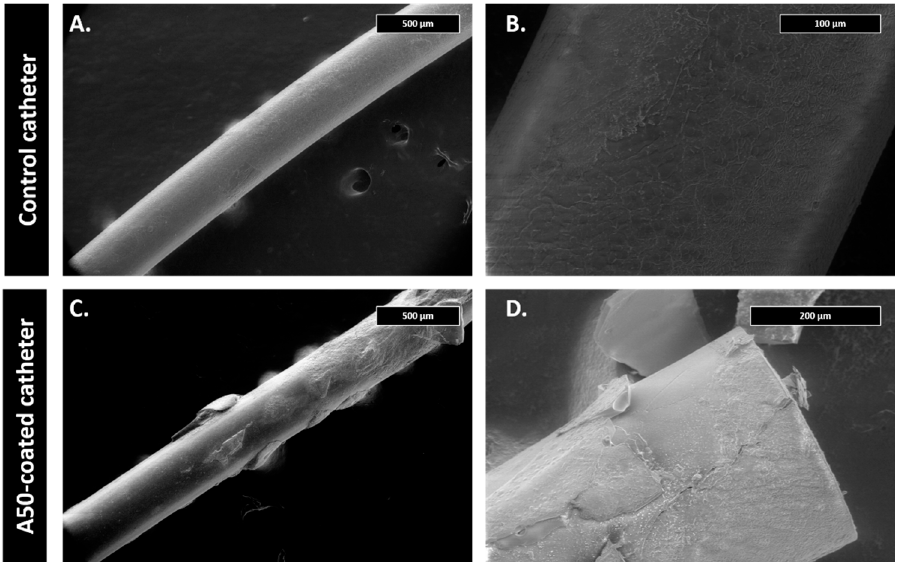
Figure 9. Scanning electron microscopy micrographs of each type of catheter after 28 days in the marginal ear vein from the coagulation model at 50 × ( A , C ), and 200 × magnifications ( B , D ).